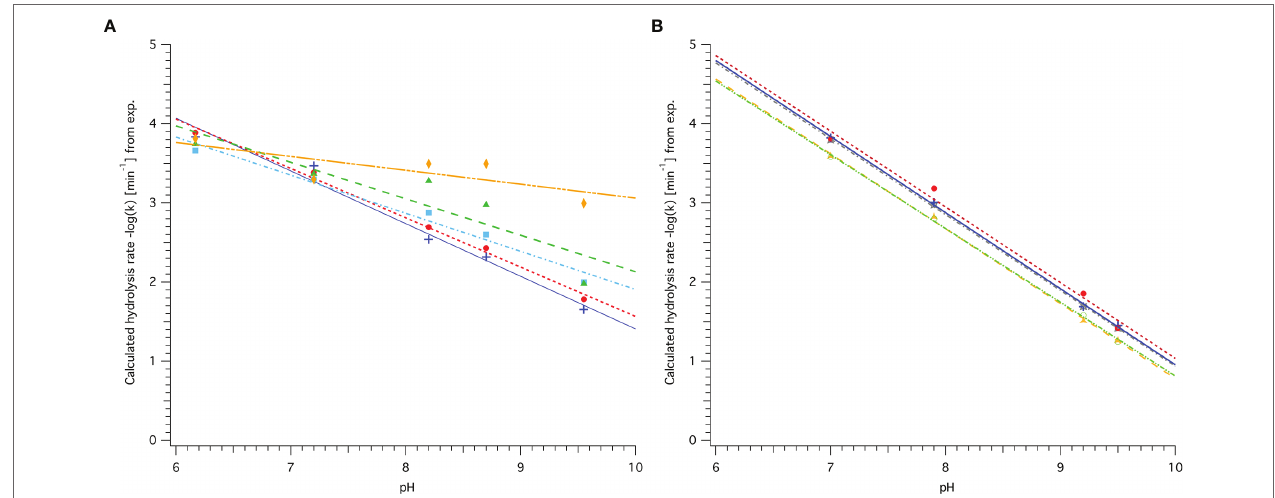
FIGURE 2 | pH-dependence of hydrolysis rate k for different AHLs. (A) Based on data published by Decho et al. (2009) for C6 (blue, crosses), C8 (red, circles), C10 (light blue, squares), C12 (green, triangles) and C14 (orange, diamonds). (B) Based on data published Ziegler et al. (2019) for C4 (grey, stars), C6 (blue, crosses), C8 (red, circles), C6-oxo (orange, triangles) and C8-oxo (light green, open circles). Coefficients for linear least-square fit following the equation − log ( k )= a × pH + C are detailed in Table 1